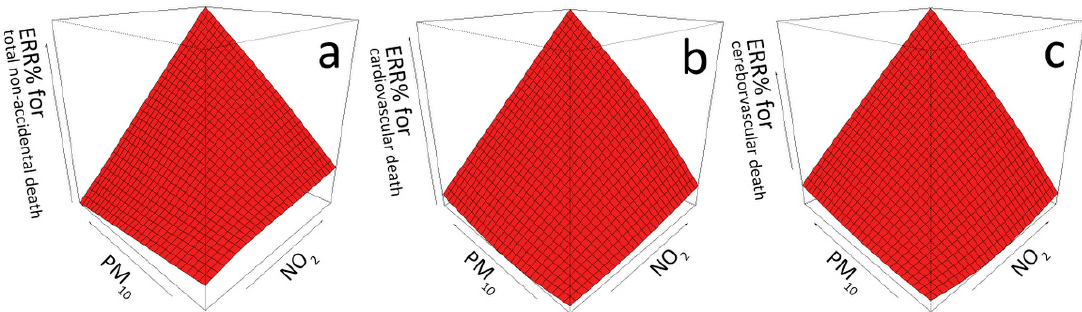
Figure 3. Joint effect graphs of lag 0–2 days PM 10 and NO 2 on mortality. This figure visualizes the strength change of excess relative risk percentage (ERR%) of PM 10 and NO 2 concentrations at lag of 0–2 days on mortality. Subgraphs a, b and c of the figure are joint effect graphs of the two air pollutants for three subsets of mortality (non-accidental death, cardiovascular death and cerebrovascular death), respectively. Table 4. ERRs (%) with 95% confidence intervals for mortality for each 10 µ g/m 3 increment of lag 0–2 days PM 10 across NO 2 levels.